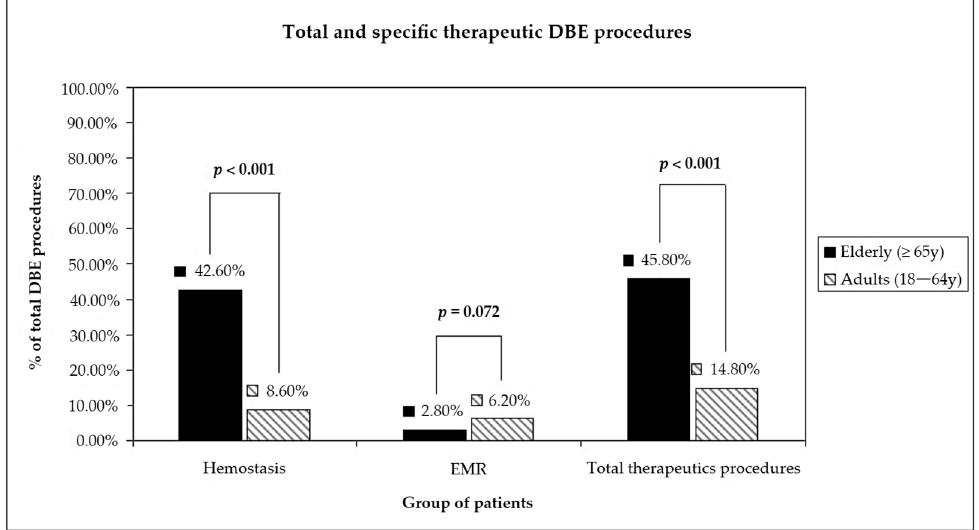
Figure 3. Difference in term of therapeutic yield between elderly and adults.